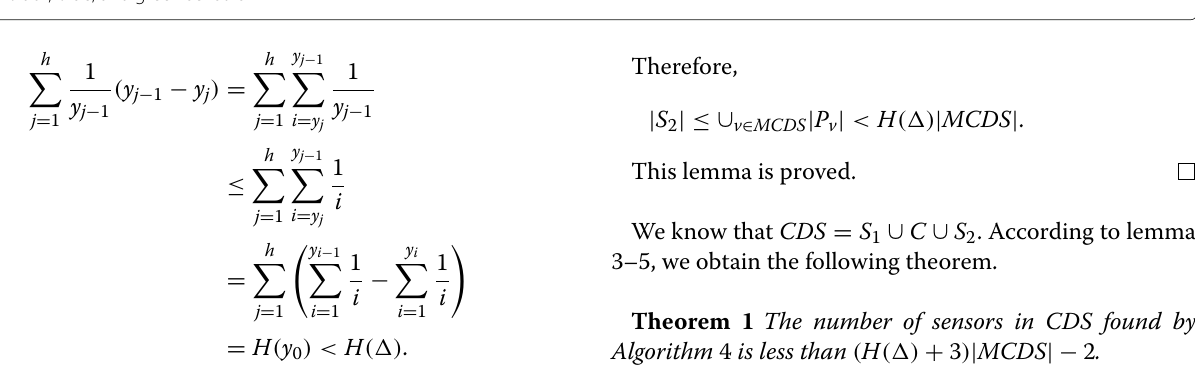
Fig. 3 Let the transmission range R be 250 m and deploy 100 sensors in the 1000*1000 m 2 detection area. The execution process of the Algorithm 4 as follows: a Select a sensor s to start S 1 construction and sensor s is marked black. b An independent set S 1 that contains four black sensors is constructed in step 1. c The connector set C that contains six blue sensors is constructed after executing step 2, and we obtain a subtree that contains all cores . d The supporter set S 2 that consists of four green sensors is constructed in step 3, then we can obtain a CDS that consists of all black, blue, and green